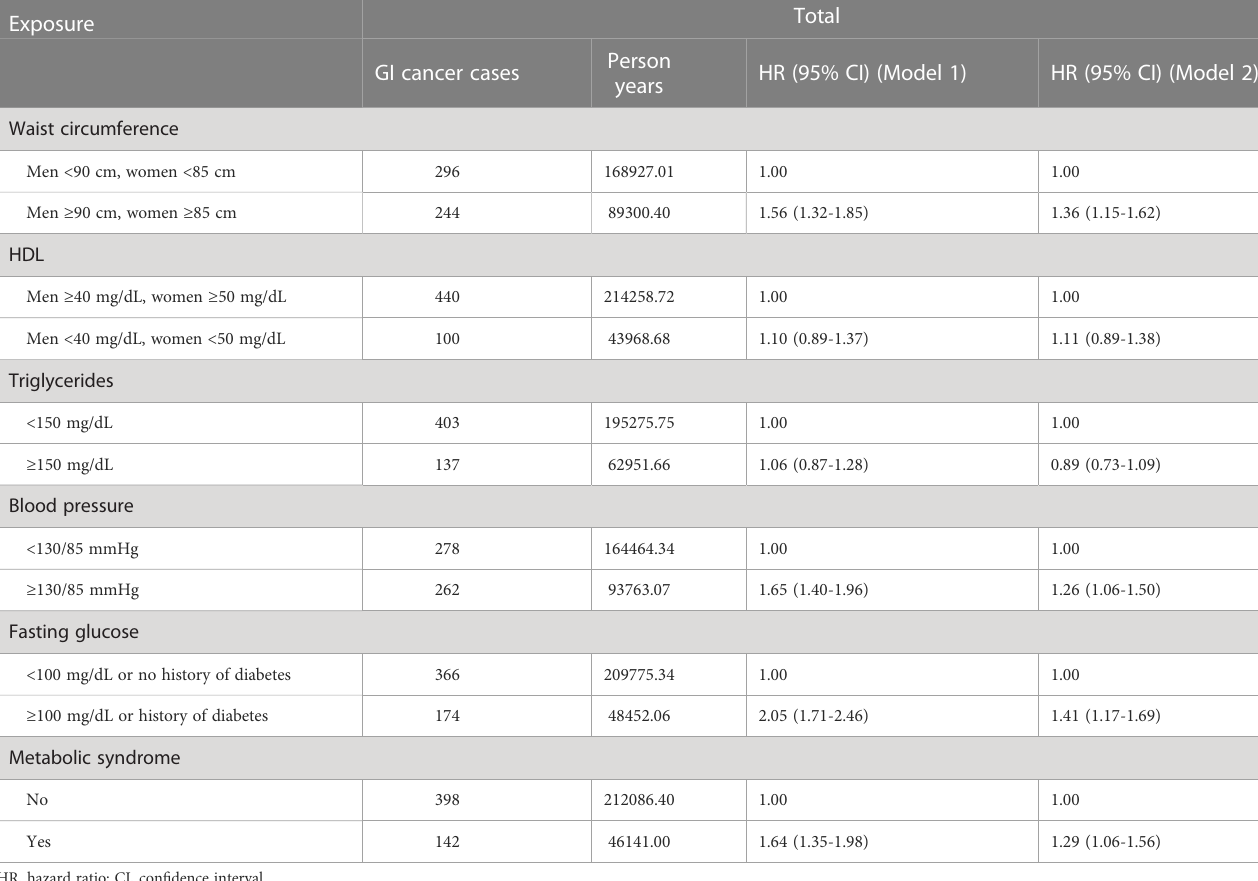
TABLE 4 Hazard ratios and 95% con fi dence intervals of incident GI related to metabolic syndrome and its components.